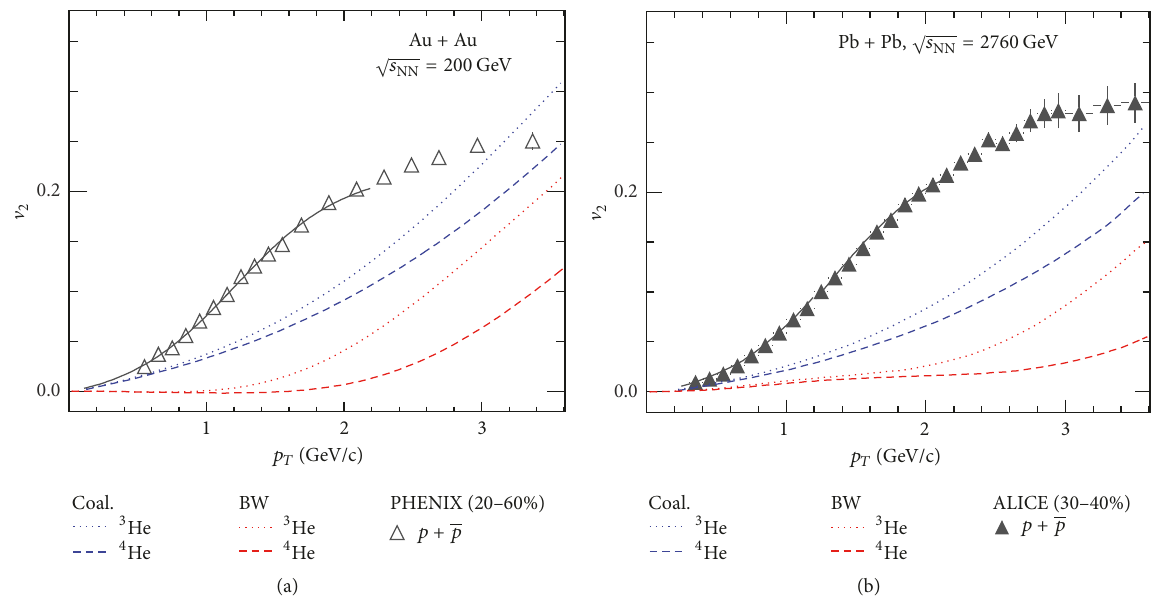
Figure 10: (a) Coalescence model predictions (blue lines) of 3 He and 4 He V 2 for (a) √𝑠 blast-wave predictions of 3 He and 4 He V 2 are also shown in red